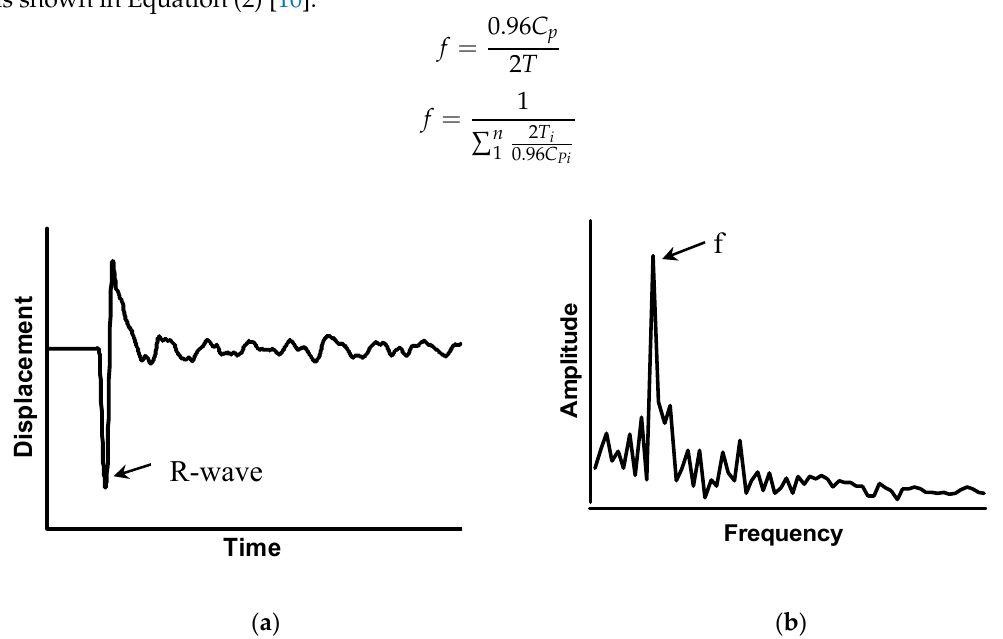
Figure 2. Representative ( a ) displacement waveform and ( b ) the amplitude spectrum for an impact–echo (IE) test performed on a plate.